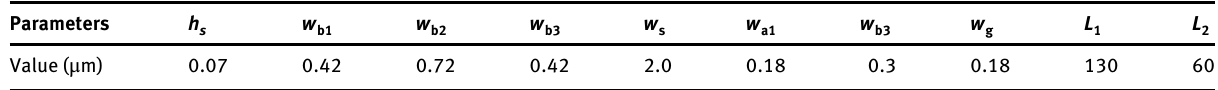
Table 2: The key parameters of the PSR.